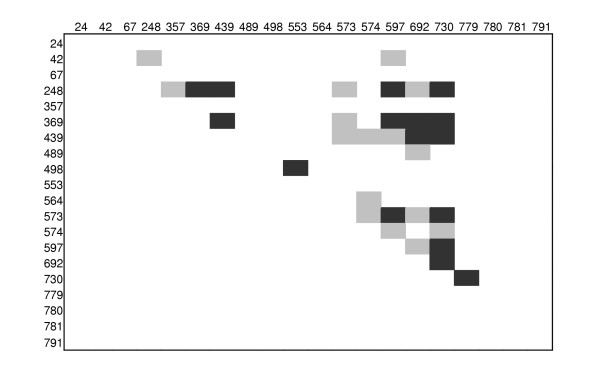
Linkage disequilibrium triangle plot for informative sites in the pre/early-vaccination sample. Significant linkage disequilibrium is indicated my shading, grey shading is P < 0.05, black shading, P < 0.001 by Fisher's exact test.